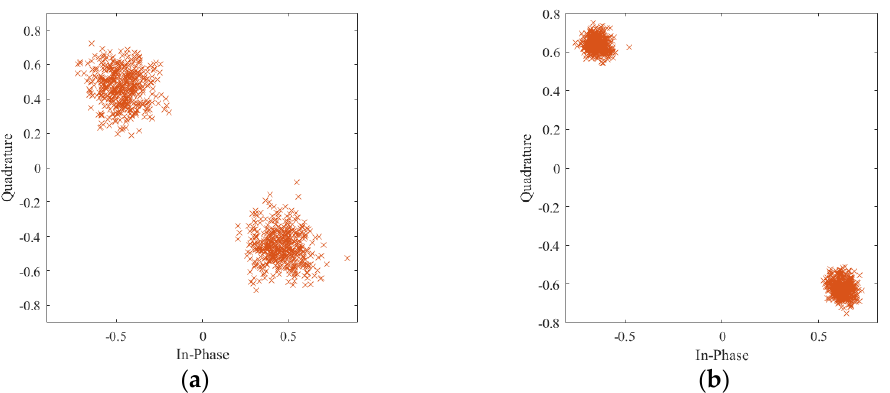
Figure 3. Symbol constellation diagram of measured DTMB signal without phase rotation: ( a ) before noise reduction; ( b ) after noise reduction.